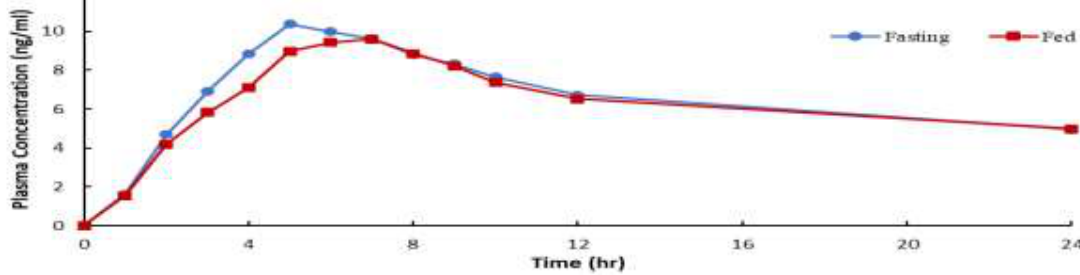
Figure 2 .Comparison of mean plasma concentration-time profiles (t=0-24 hr) of fluoxetine after administering fluoxetine 20 mg capsules to healthy adult Arabic subjects under fasting and fed states.